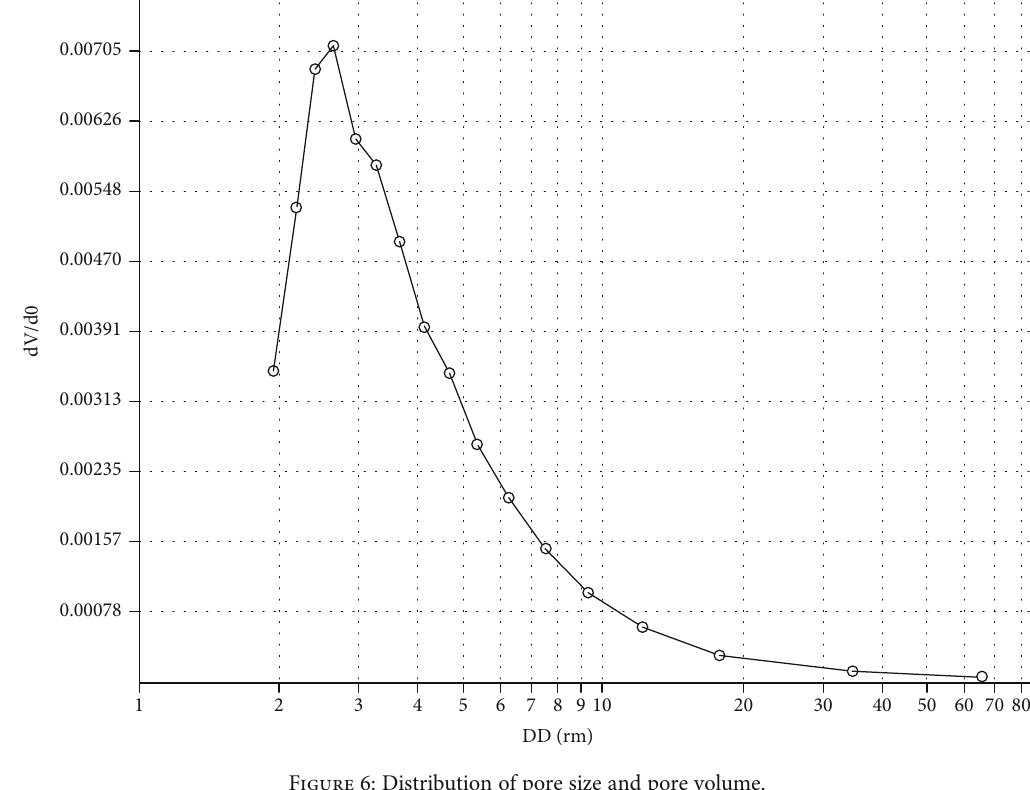
Figure 6: Distribution of pore size and pore volume.